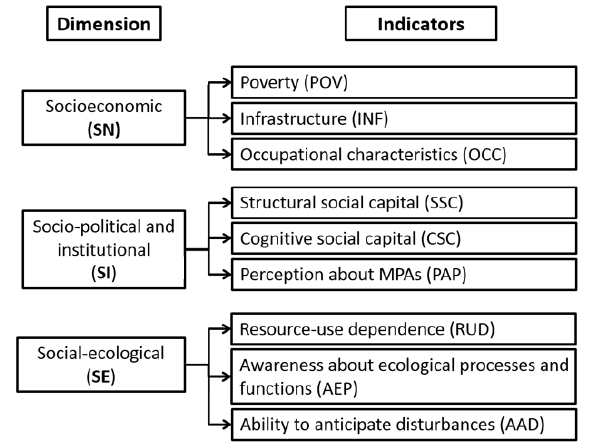
Fig. 1 . Proposed dimensions and indicators to measure adaptive